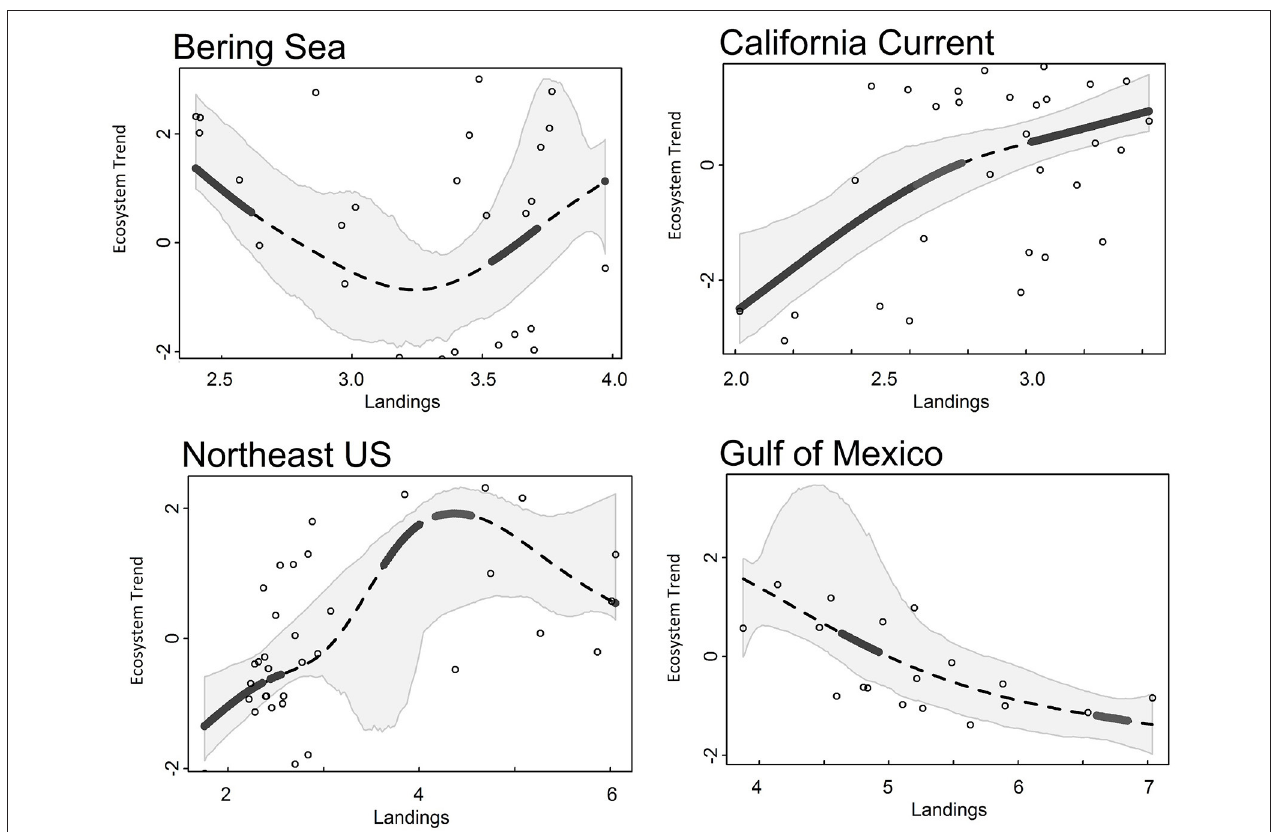
FIGURE 5 | Ecosystem trend (Trend 1 for all LMEs) responses to landings (t km − 2 ) from Alaska (Bering Sea), California Current, Northeast US, and Gulf of Mexico ecosystems. Dotted lines are the smoothed GAM line, gray polygons surrounding the trend line are 95% CI, solid black lines indicate a significant threshold